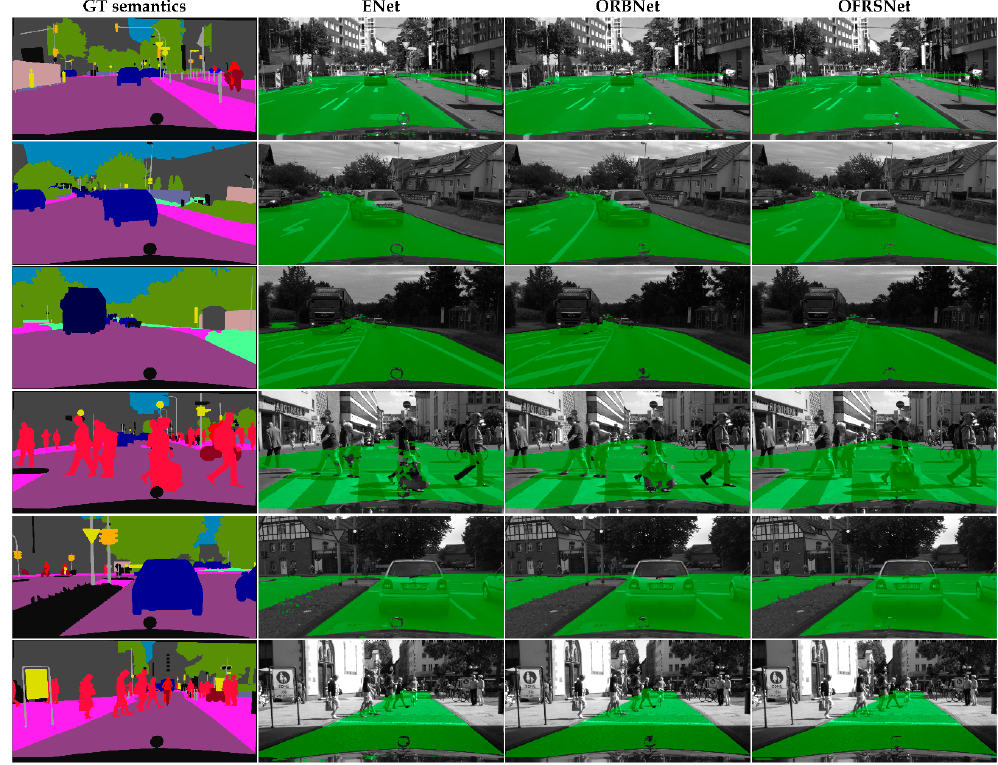
Figure 9. Qualitative results on the Cityscapes dataset using ground truth semantics as input. Green represents the detected full road